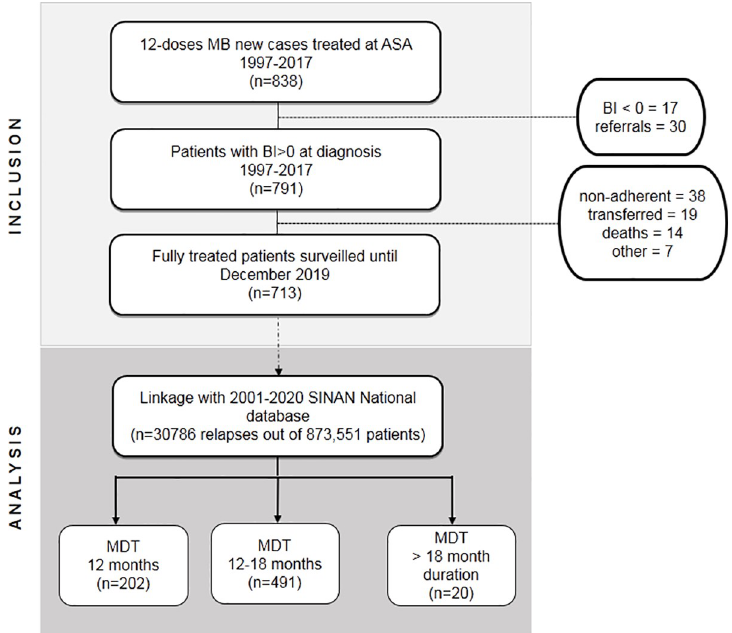
Fig 1. Flow-diagram of the Fiocruz Hansen disease Reference Center Cohort. The inclusion criteria considered patients who exhibited a BI higher than 0 at diagnosis, were treated with the 12-dose MB-MDT scheme between 1998– 2018, and who were followed-up at the Souza Araujo Outpatient Clinic after release from treatment. Patients were followed-up at least annually (except for those censored because of age or death). Linkage of the clinic data with the National HD registry SINAN database was performed to retrieve any relapse cases not diagnosed at the clinic due to change of address. Then, the patients in the follow-up cohort were grouped according to the length of the 12-dose MB-MDT treatment. BI, bacillary index; MB, multibacillary; MDT, multidrug therapy.